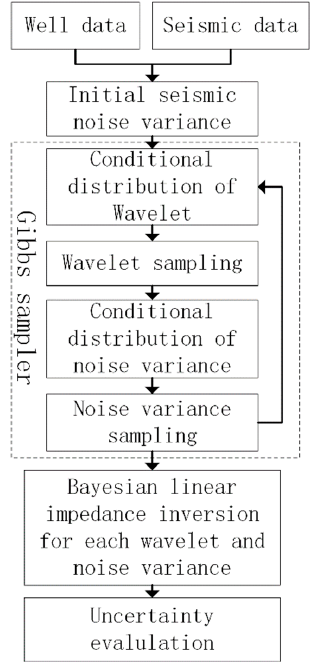
Figure 1. Workflow of inversion.